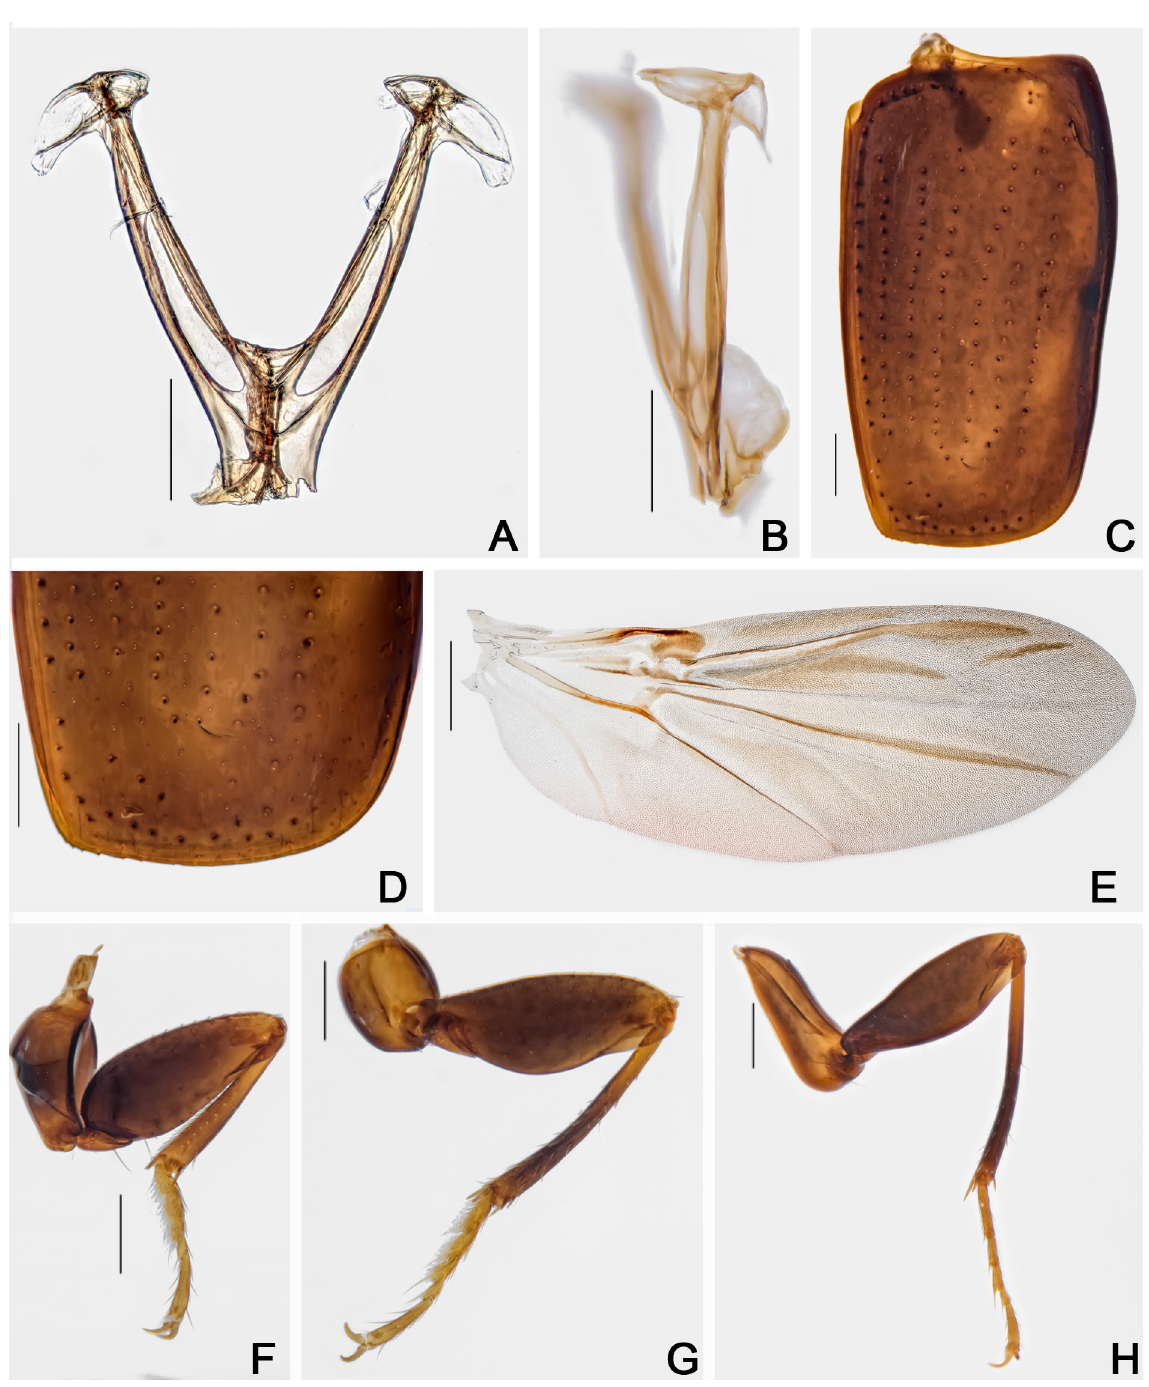
Fig. 18. Cyparium lescheni sp. nov., paratype, ♂ (CELC). A–B . Metendosternite. A . Dorsal view. B . Lateral view. C–D . Elytron. C . Entire. D . Apex. E . Hind wing. F–H . Legs. F . Fore. G . Middle. H . Hind. Specimen collected at Mata do Paraíso, Viçosa (MG, Brazil). Scale bars: A–D, F–H = 0.2 mm; E = 0.5